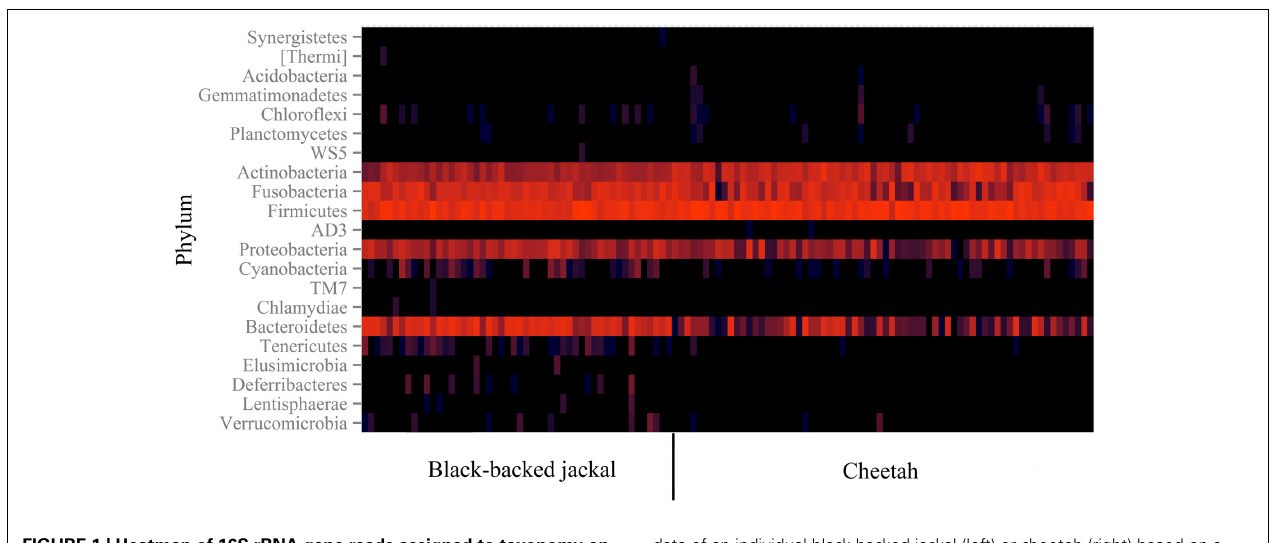
FIGURE 1 | Heatmap of 16S rRNA gene reads assigned to taxonomy on the bacterial phylum level. The color encodes the abundance of OTUs (log-scale of base 4) allocated to a specific phylum. Each column represents